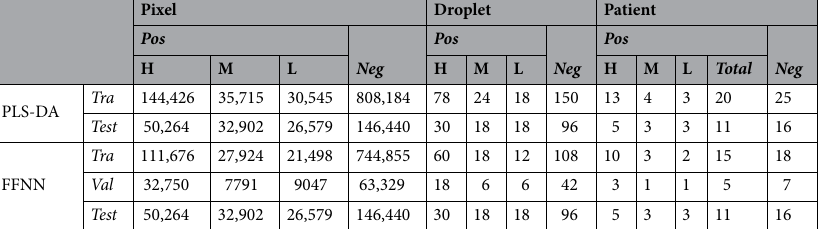
Table 2. Experiment 2: Sample distribution of nasopharyngeal exudates at different levels (total numbers of patients, droplets and pixels) among the experimental Training (Tra), Validation (Val), and Test groups (Trial 1). Positive (Pos) and negative (Neg) cases were determined by qRT-PCR. Positive cases include three viral load levels (H = 10 6 copies mL −1 , M = 10 4 copies mL −1 and L = 10 2 copies mL −1 ). Note that classification algorithms provide results as (per-pixel, per-droplet and per-patient) ‘positive’ (with any level of viral load) or ‘negative’ assignations. PLS-DA partial least square-discriminant analysis, FFNN feed-forward neural